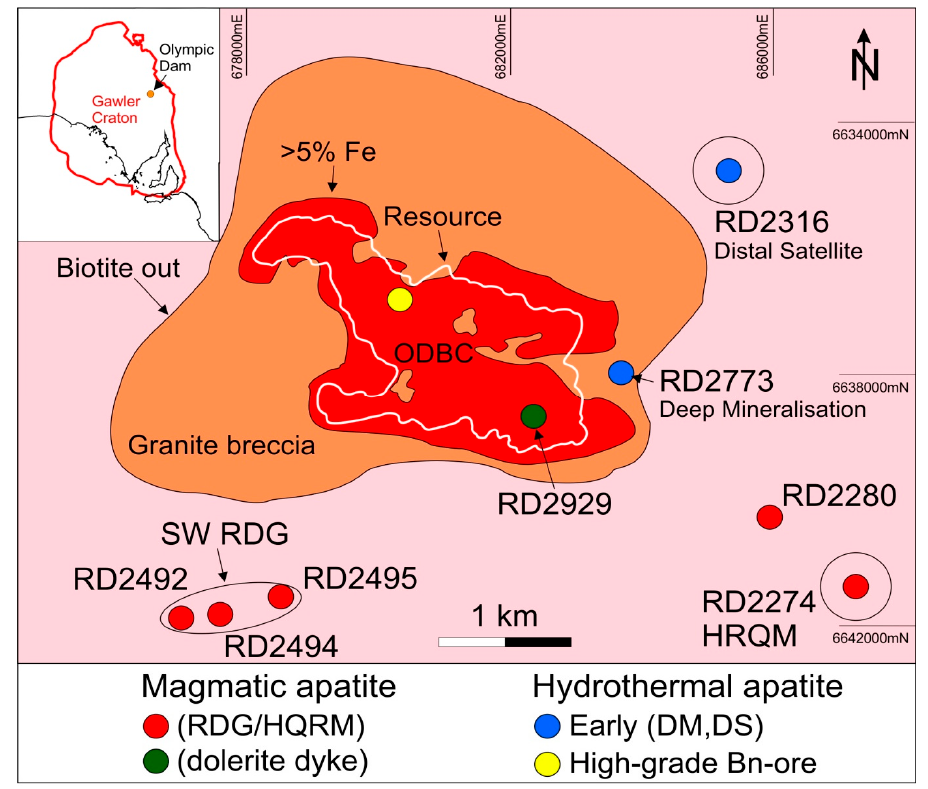
Figure 1. Geological sketch map of the Olympic Dam deposit at Relative level − 350 m showing the location of the sampled drillholes/studied samples (modified from [19]). The insert map shows the location of Olympic Dam with respect to the Gawler Craton and South Australia.